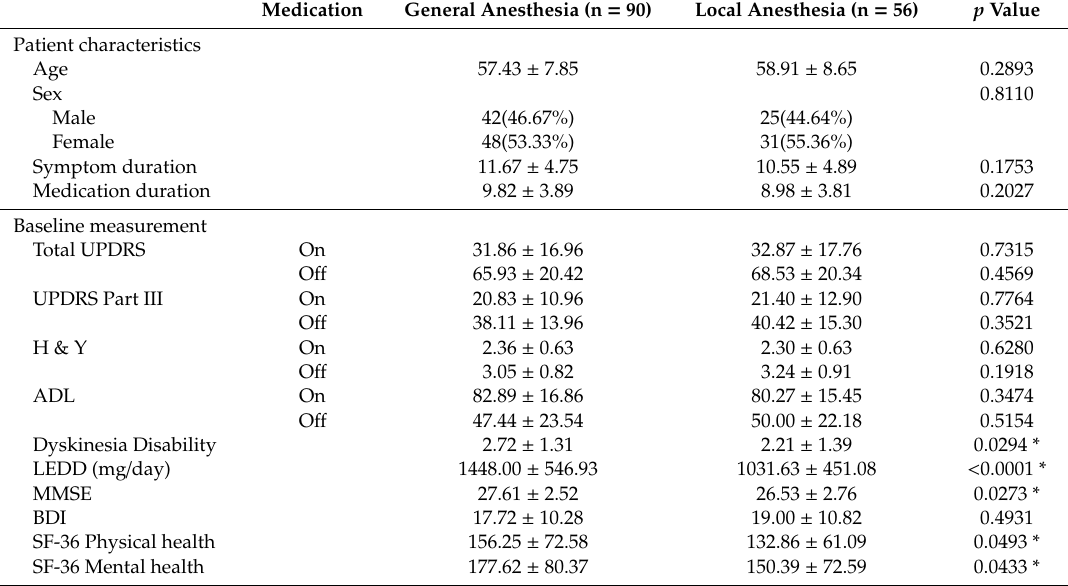
Table 5. Patients’ characteristics and clinical measurements in patients who underwent bilateral subthalamic nucleus deep brain stimulation under local and general anesthesia.